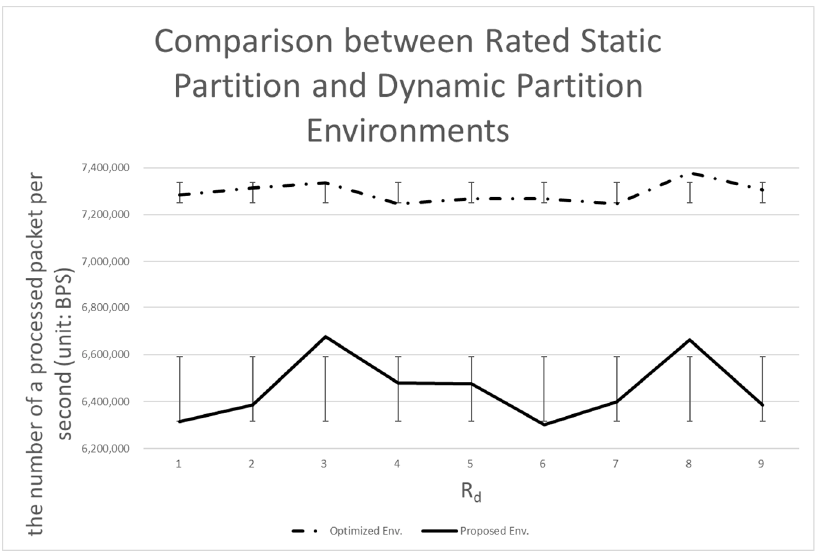
Figure 15. Comparison between a rated static partition and the dynamic partition environment.